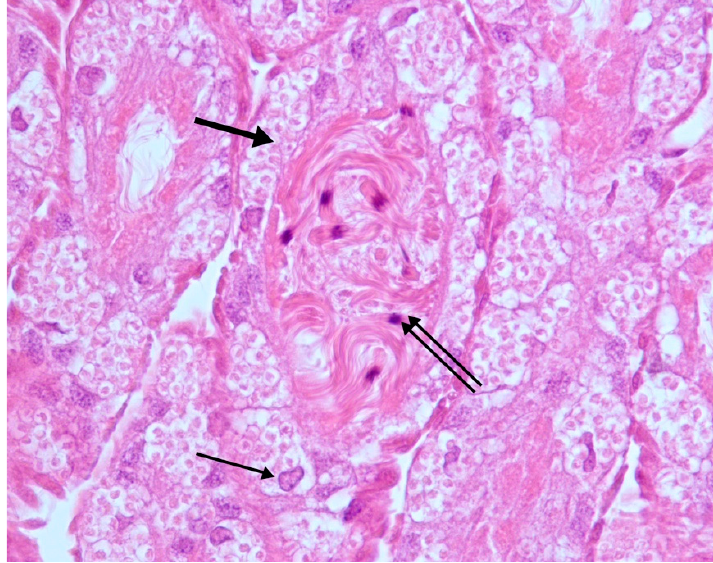
Figure 1. Testes. Normal seminiferous tubules. Follicular (thin arrow) and germ cells (thick arrow); coiled spermatozoa in the lumen of the tubules (double arrow). H-E 40×.